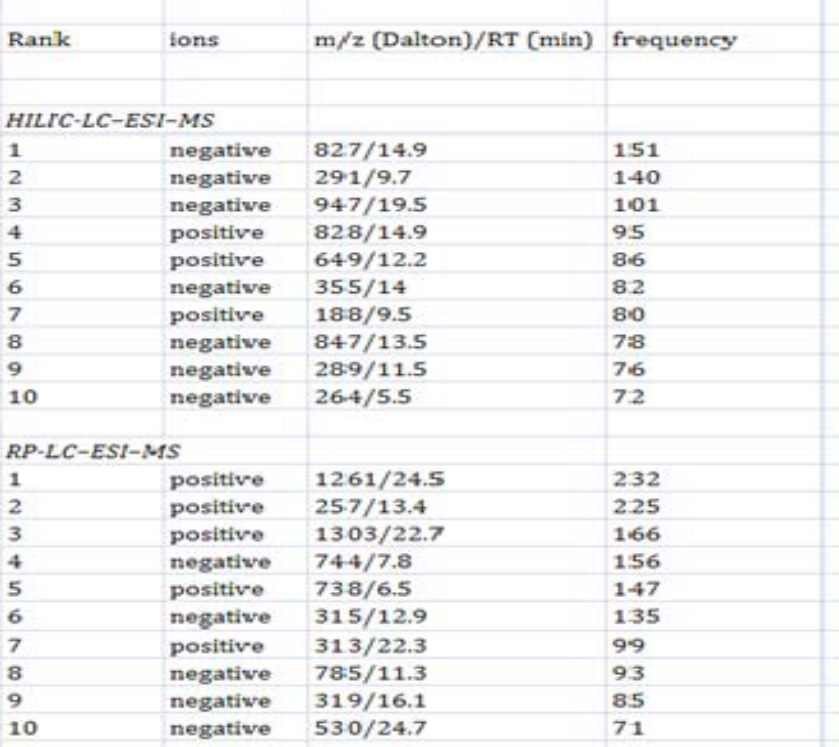
Table 3. Top 10 classifiers from HILIC-LC-ESI-MS and RP-LC-ESI-MS datasets (MarkerView 1.1 peak